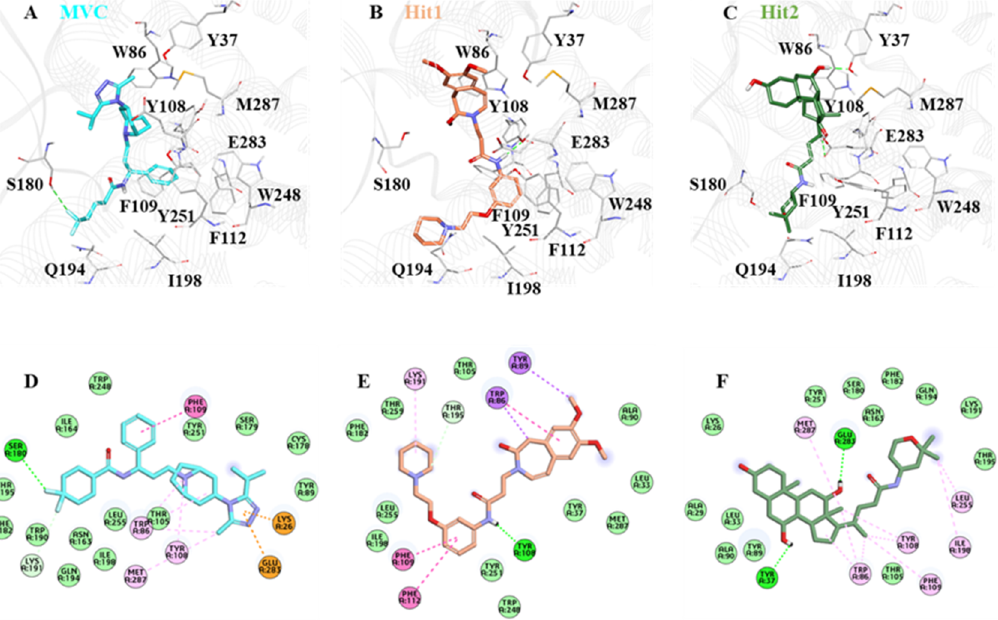
Figure 8. The binding mode of ( A ) MVC, ( B ) Hit1, and ( C ) Hit2. MVC, Hit1, and Hit2 are shown in cyan, brown, and green, respectively. The lower panel of the image represents the 2D molecular interactions of ( D ) MVC, ( E ) Hit1, and ( F ) Hit2, with active site residues. The hydrogen bonds are shown with a green dashed line while π-π, π-alkyl, π-cation, π-sulfur, and π-σ interactions are shown as pink, orange, yellow, and purple dashed lines, respectively. Table 3. The detailed inter-molecular interactions of MVC, Hit1, and Hit2 with CCR5, obtained after 100 ns MD simulation.